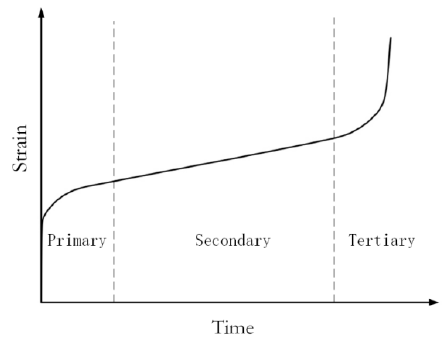
Figure 4. The three creep stages of the polymers.